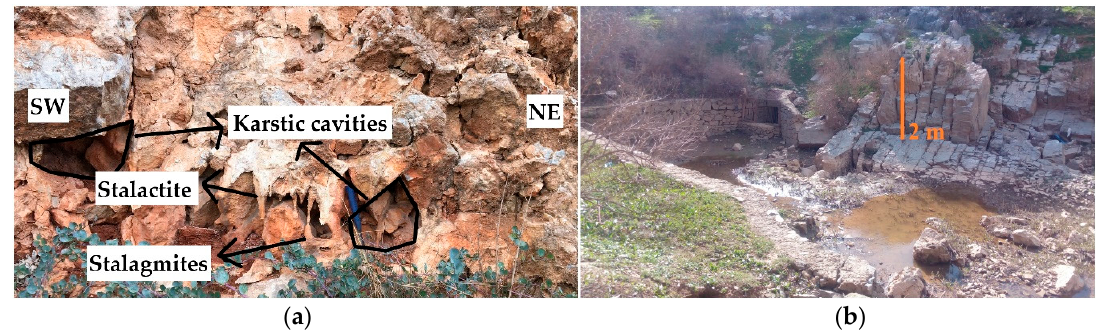
Figure 4. ( a ) Karstification in the cherty dolomitic limestone (JKu) [45]; ( b ) The sinkhole in the dolomitic limestone (JKmu) at the Karabaglar Plain in a drought